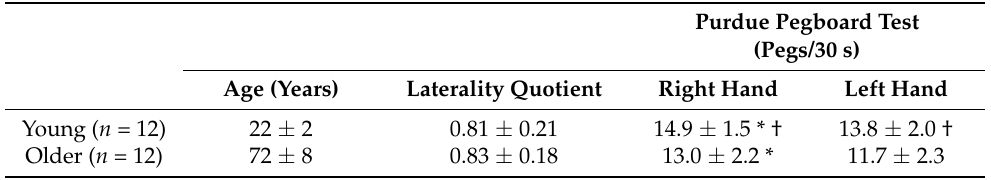
Table 1. Participant handedness characterization. Data represent means ± S.D. for age and hand